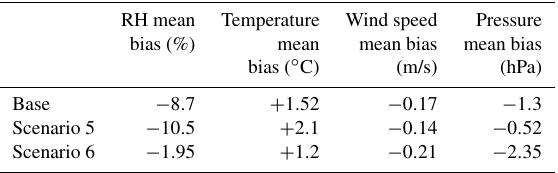
Table 3. Performance (expressed as mean bias) of different scenar- ios to predict meteorological parameters during lockdown.